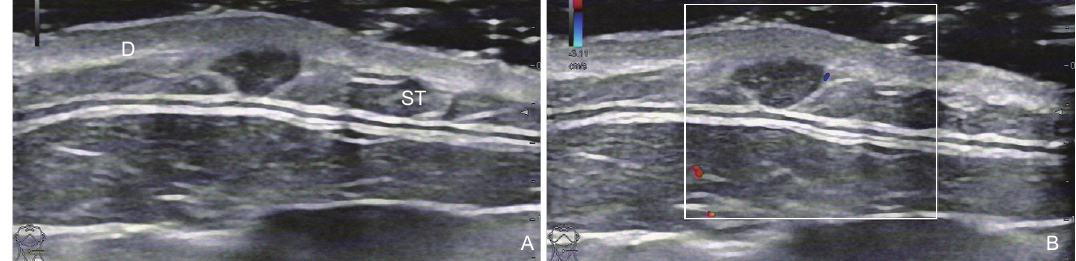
Figure 2 A epidermoid cyst bellowed dermis (D) and in subcutaneous fat layer (ST). (A) Ultrasound scan found a 6×3mm irregular-shaped hypoechoic cystic lesion in subcutaneous fat layer; (B) Color Doppler showed no blood flow signals in the lesion.